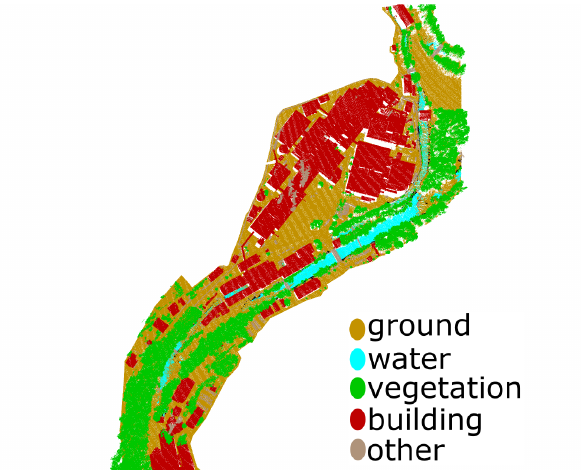
Figure 4. Overview of the semantic labels from the data of 2012, manually